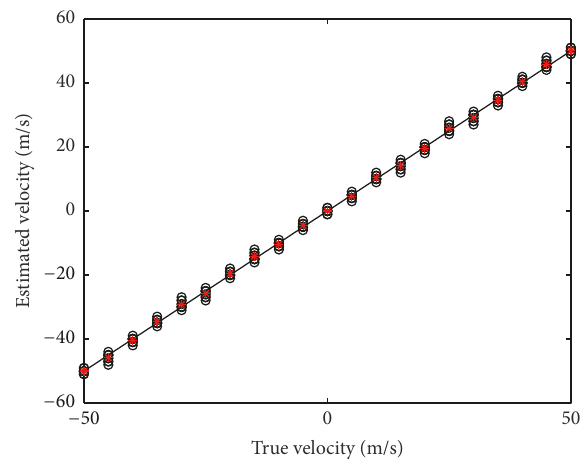
Figure 1: The true velocity (solid line) versus estimated velocities (hollow dot) from 30 simulations when CSR = 20 dB and SNR = 40 dB using PTDM. The mean of estimated velocities of each input velocity is shown as a red asterisk character.